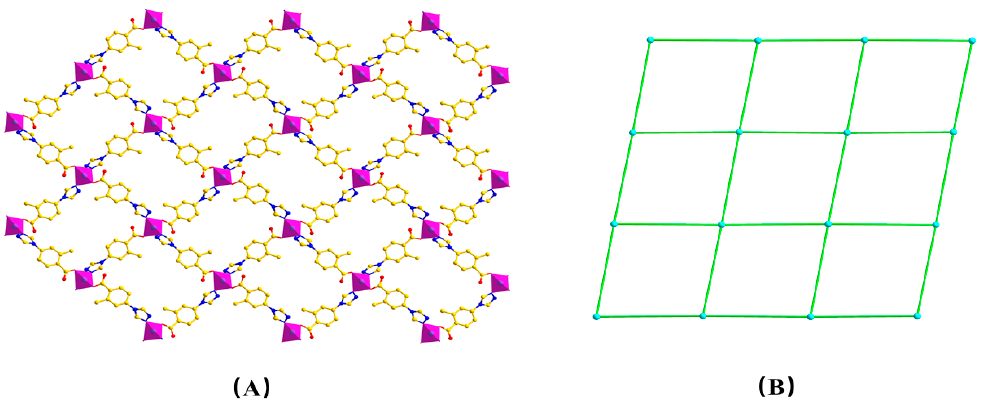
Figure 2. ( A ) 2D structure in 1 . ( B ) A view of (4, 4) topology in 1 .